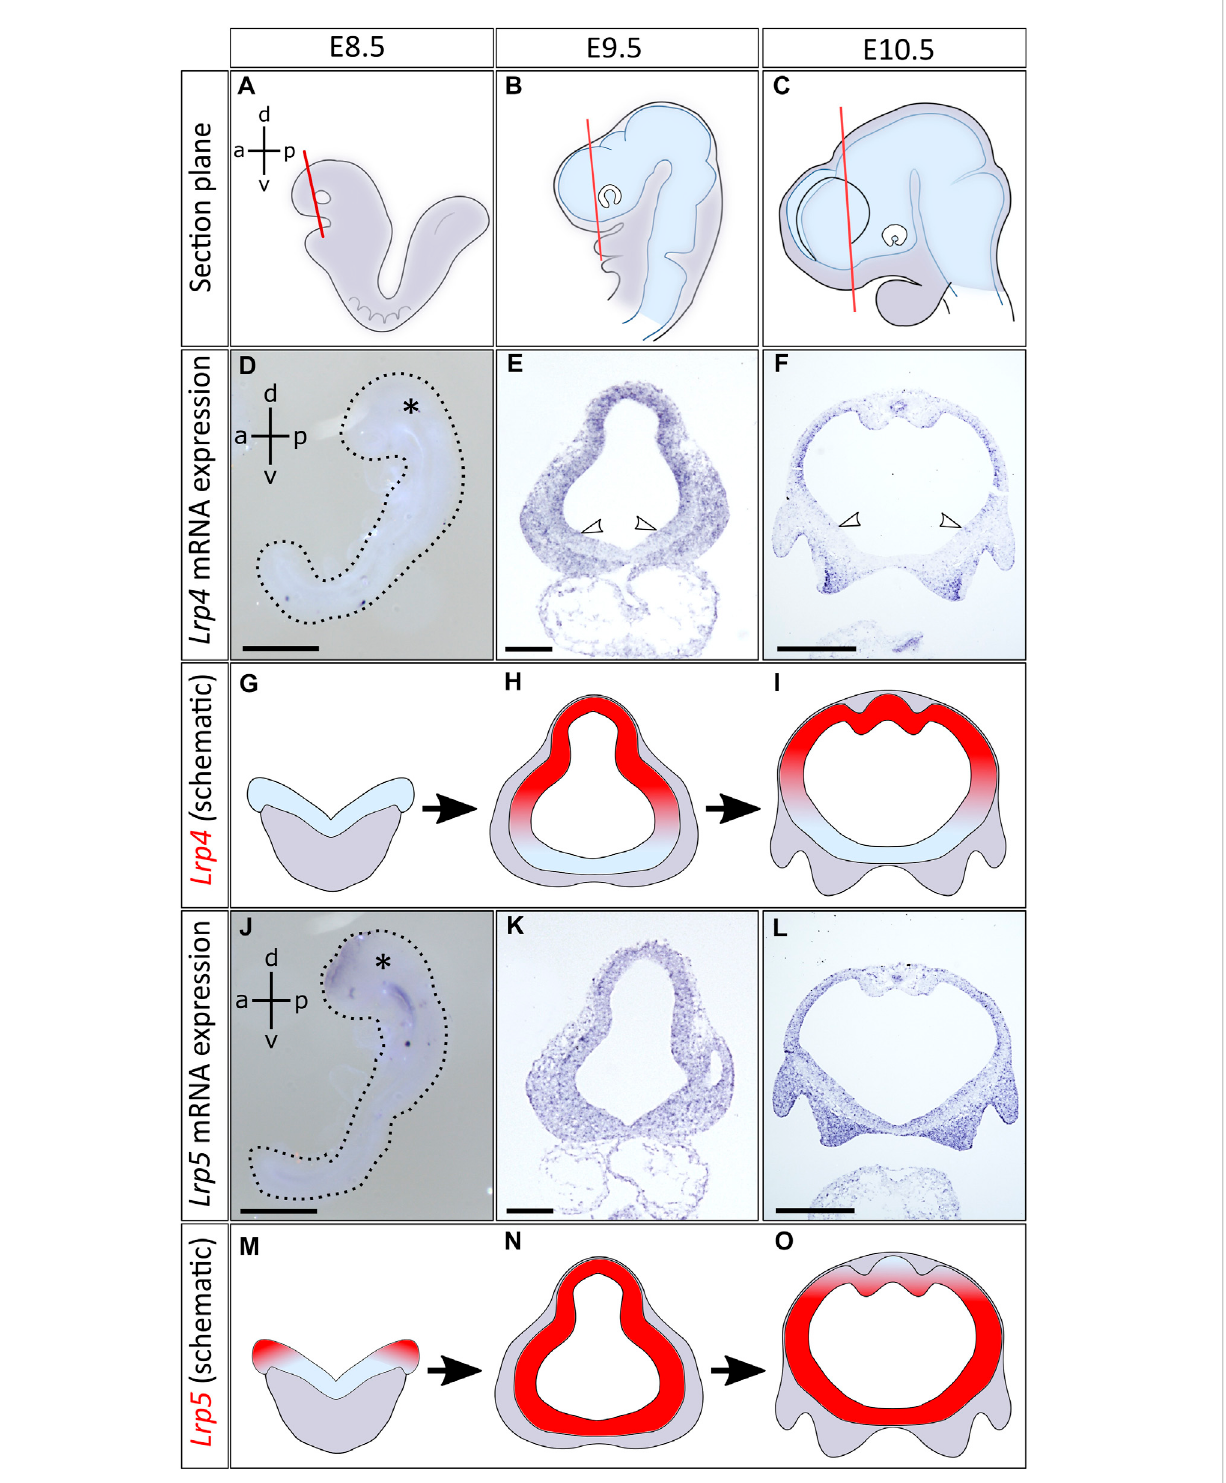
FIGURE 1 Distinct and overlapping expression of Lrp4 and Lrp5 mRNA in the early developing neural tube. (A – C) Schematics indicate planes of coronal sections of mouse embryonic forebrains, anterior to the optic cup, between embryonic stages E8.5 and E10.5. Images of further section planes are presentedinSupplementaryFigureS1. (D) Lrp4 mRNAexpressioncouldnotbedetectedbywholemount insitu hybridization(ISH)atE8.5(wholeembryo atE8.5,lateralview,asteriskmarksthehead,dorsoventral-(d-v)andanteroposterioraxis(a-p)areindicated,scalebar:100 μ m, n =4embryos). (E) At E9.5 Lrp4 mRNA could bevisualized by ISHon coronal sections of theforebrain. Lrp4 was expressedinthe entire dorsal lateral domain of theneuraltube including the dorsal midline, while the ventral midline was always void of Lrp4 transcripts (white arrowheads: ventral border of Lrp4 expression domain, scalebar:100 μ m, n =5embryos). (F) AtE10.5 Lrp4 continuedtobeexpressedintheneuroepitheliumshowingISHsignalsinthedorsolateralbutnotinthe ventral domains of the forebrain (white arrowheads indicating the ventral border of Lrp4 expression, scale bar: 500 μ m, n = 5 embryos). (G – I)